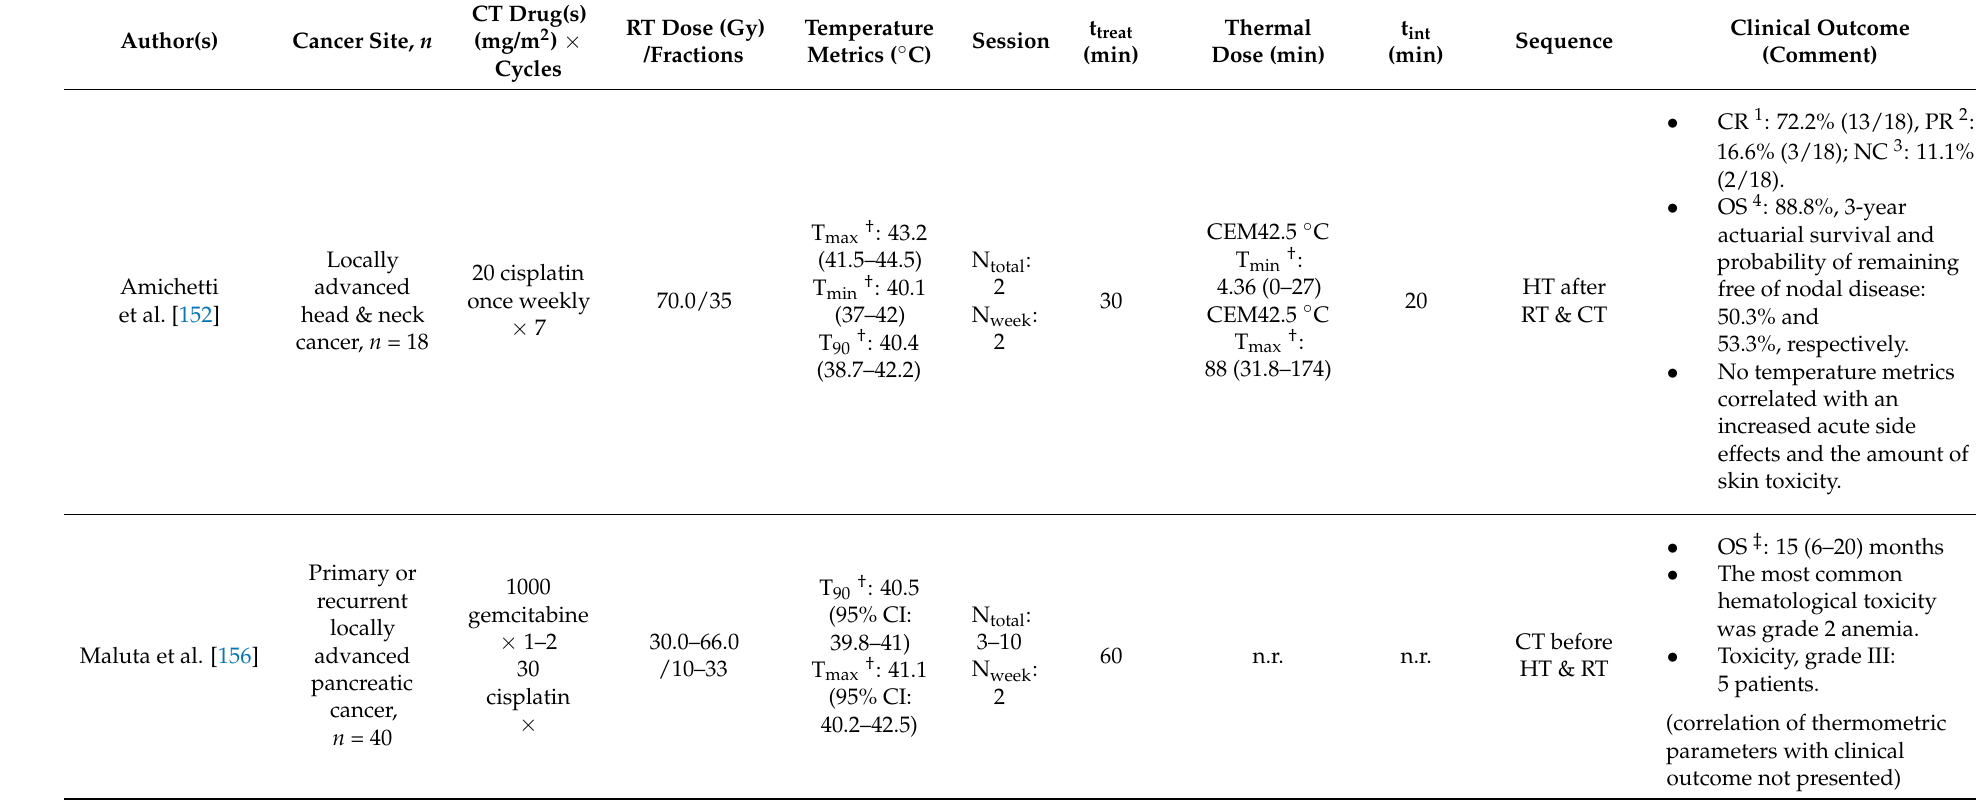
Table 11. Prospective clinical studies using RT and CT in combination with